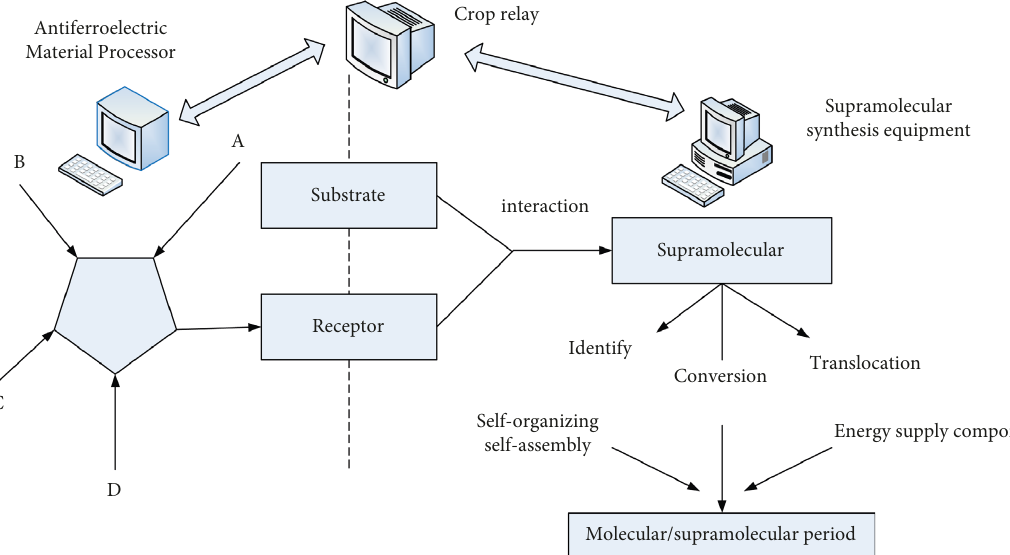
Figure 4: Supramolecular framework diagram.